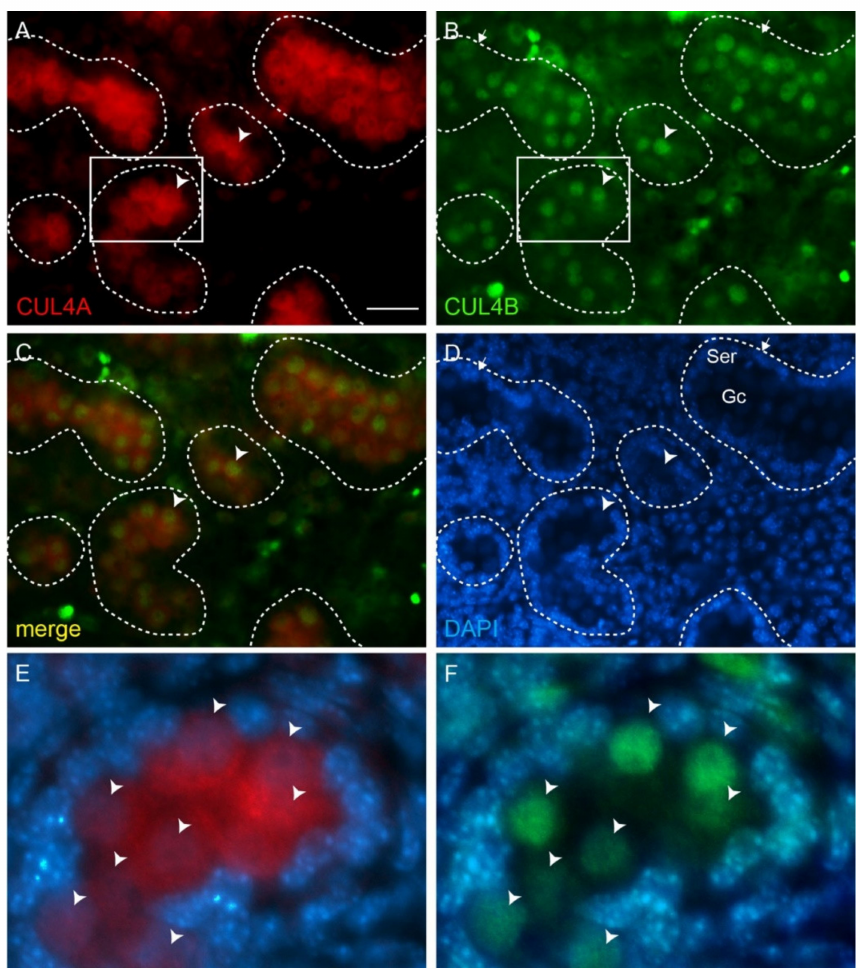
Figure 1. CUL4A and CUL4B co-localize in fetal gonocytes. ( A – F ) Immunofluorescence (IF) staining of CUL4A (red) and CUL4B (green) in E16.5 wild-type testis. Both CUL4A ( A ) and CUL4B ( B ) are highly expressed in the gonocytes (arrowheads), with CUL4B more prominent in the nuclei and CUL4A in both nuclei and cytoplasm. ( C ) shows merged CUL4A and CUL4B staining, and ( D ) shows DAPI counterstain. ( E , F ) are higher-magnitude views of the boxed areas in ( A , B ), respectively, with DAPI staining overlaid. Arrowheads point to gonocytes. Dashed lines outline seminiferous tubules. Ser, Sertoli cells; Gc, gonocytes. Scale bar 50 µ